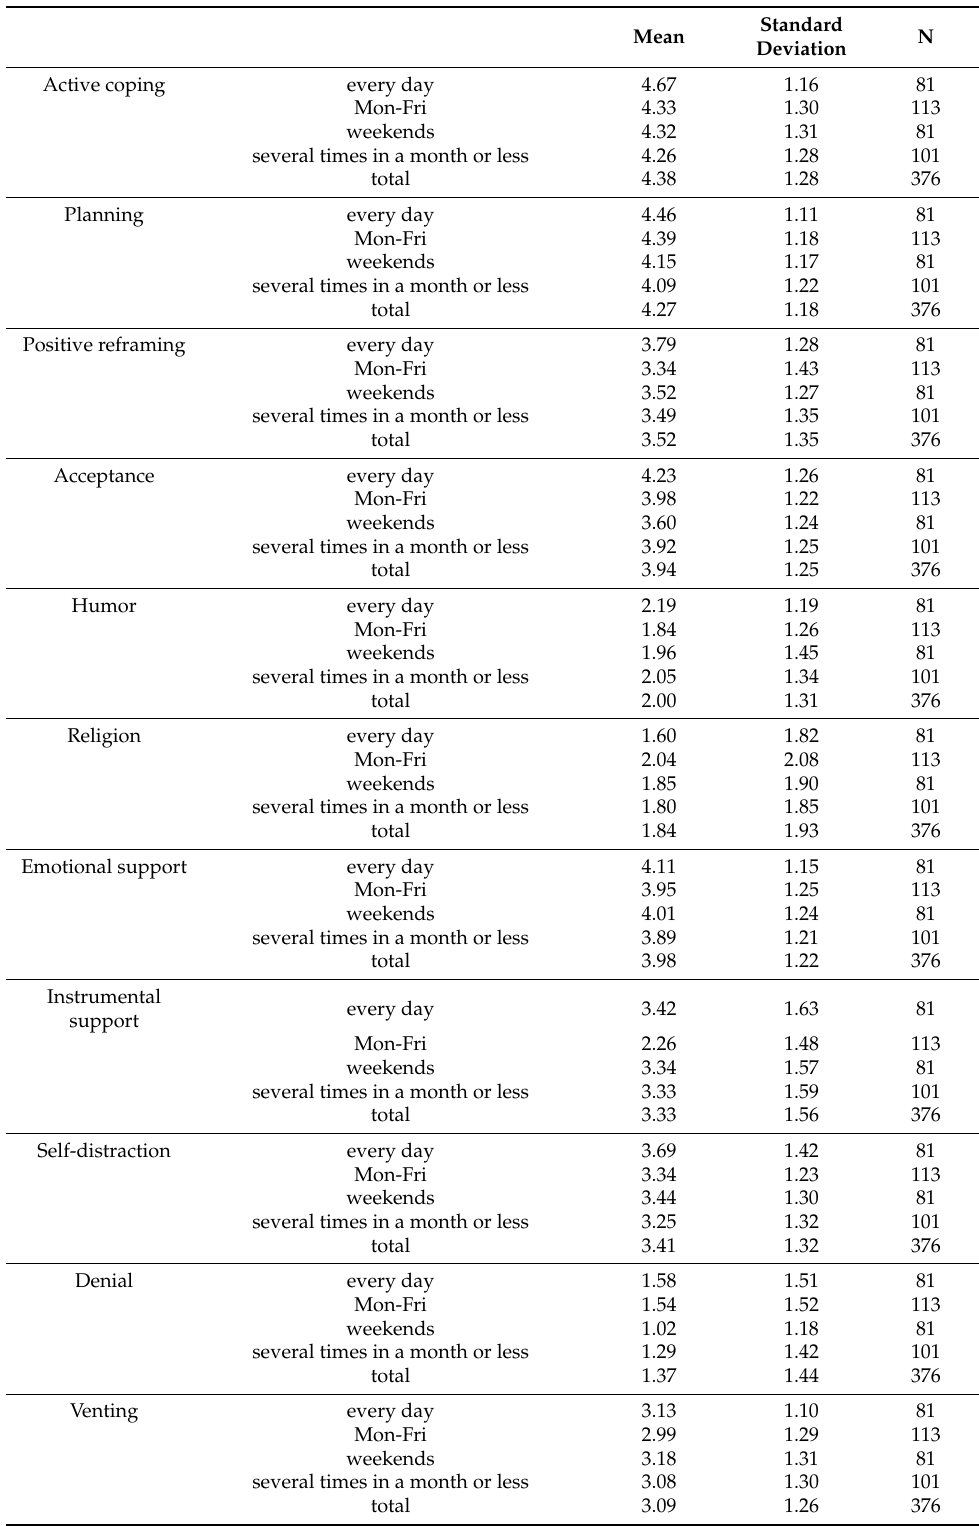
Table A1. Descriptive statistics for 14 coping strategies (Model II) in 4 groups of forest